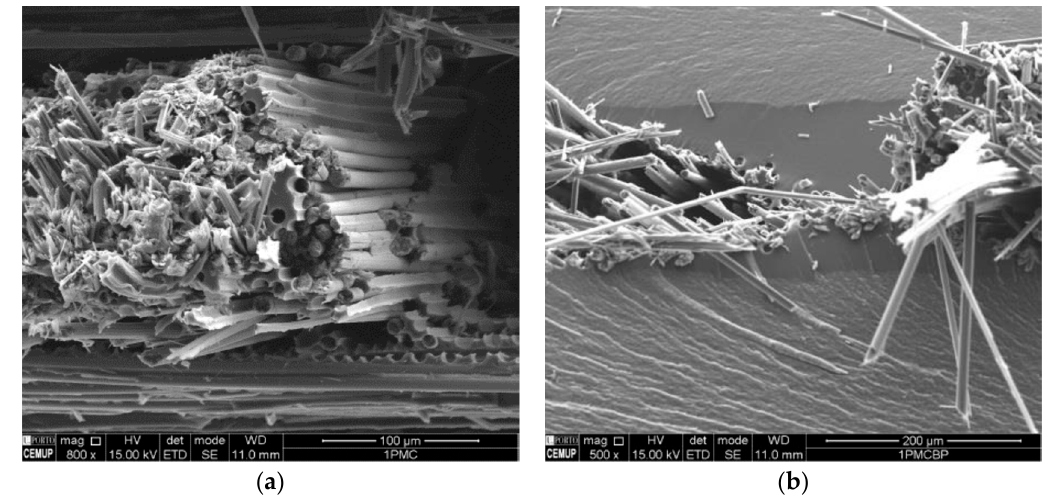
Figure 10. SEM images (through thickness) of samples PiCF-3b ( a ) and PICFBP-3 ( b ).